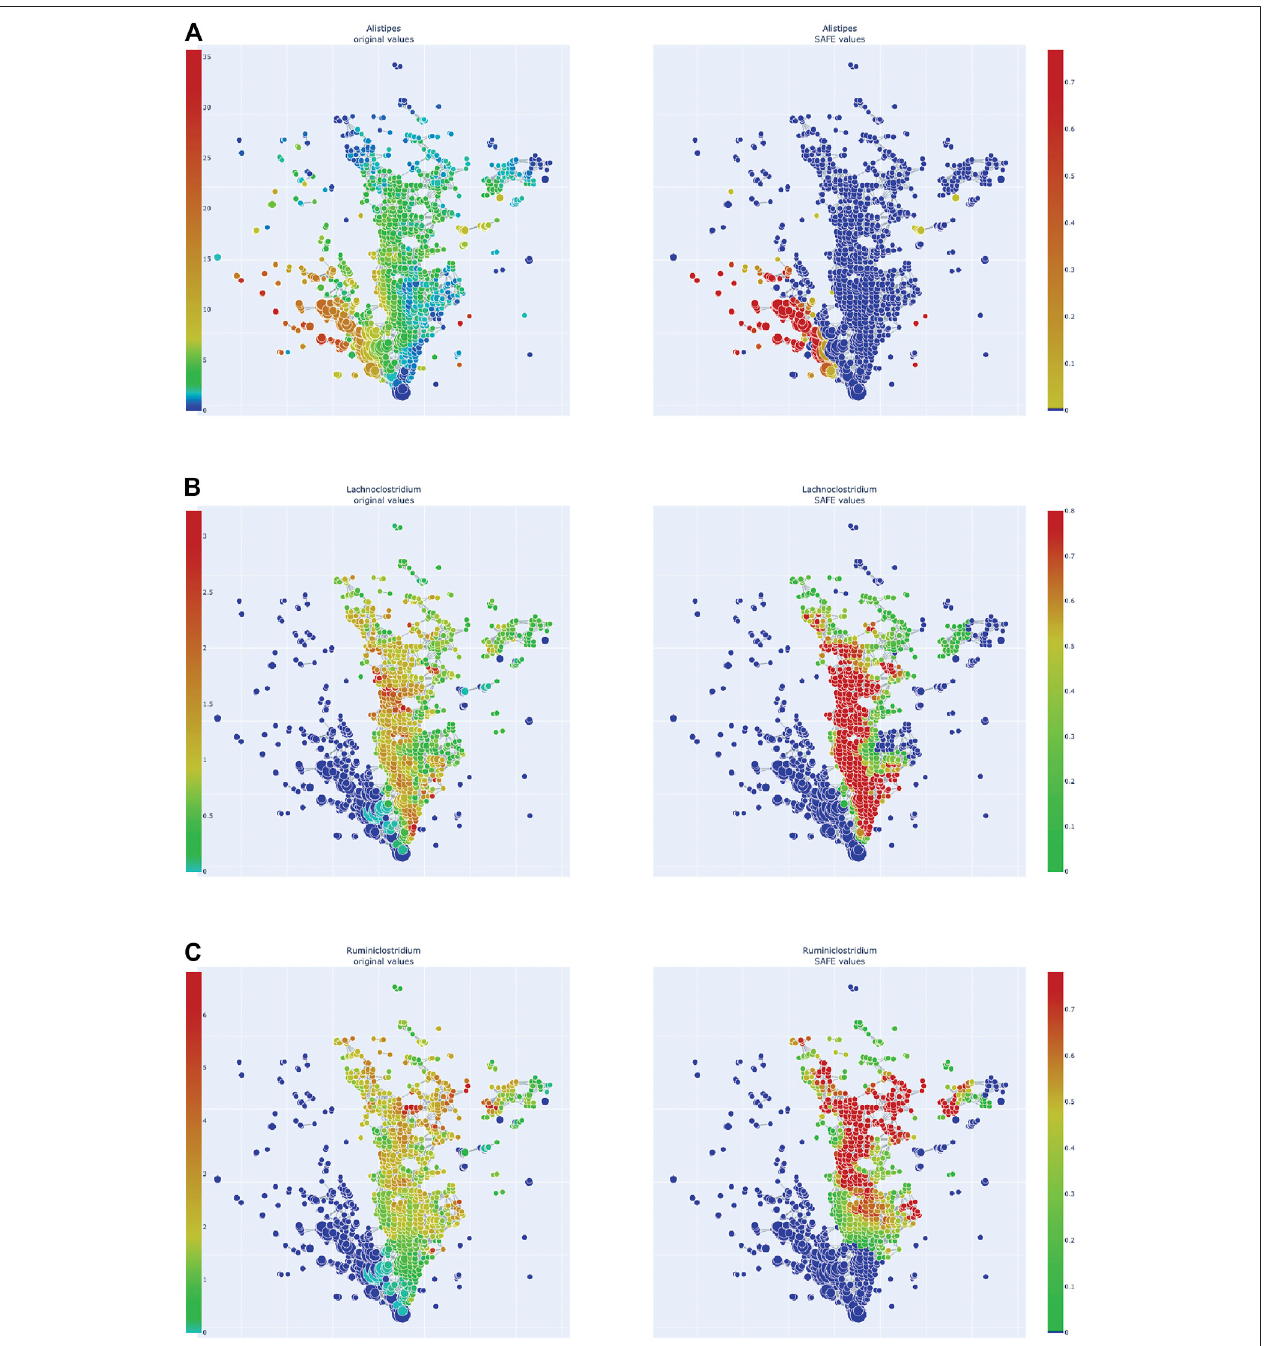
FIGURE 5 | Enrichment heatmaps of one Bacteroidetes genus and two Firmicute genera, absolute abundance across the network on the left, enrichment on the right. (A) Alistipes, of Bacteroidetes phylum . (B) Lachnoclostridium . (C) Ruminiclostridium .